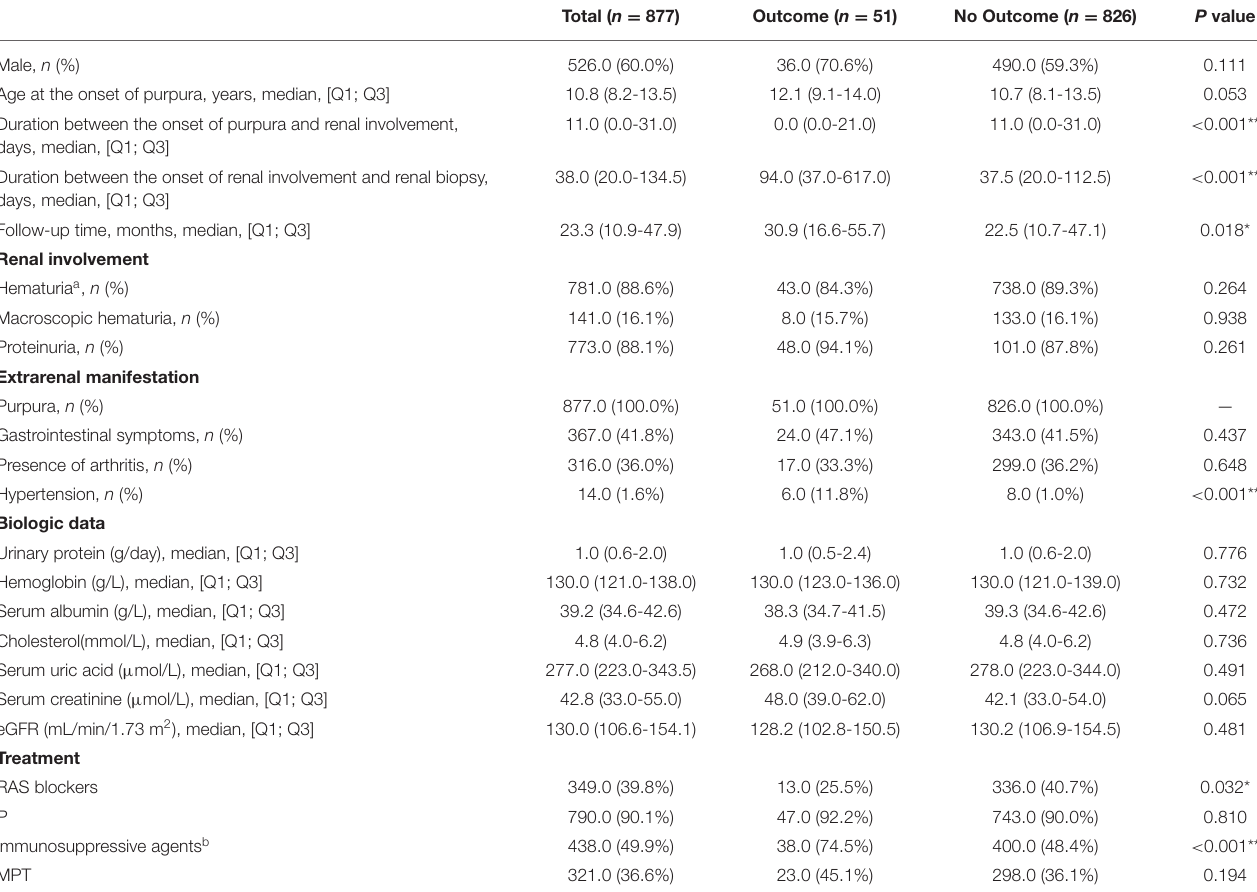
TABLE 1 | Clinical and biological data of the children with HSPN at